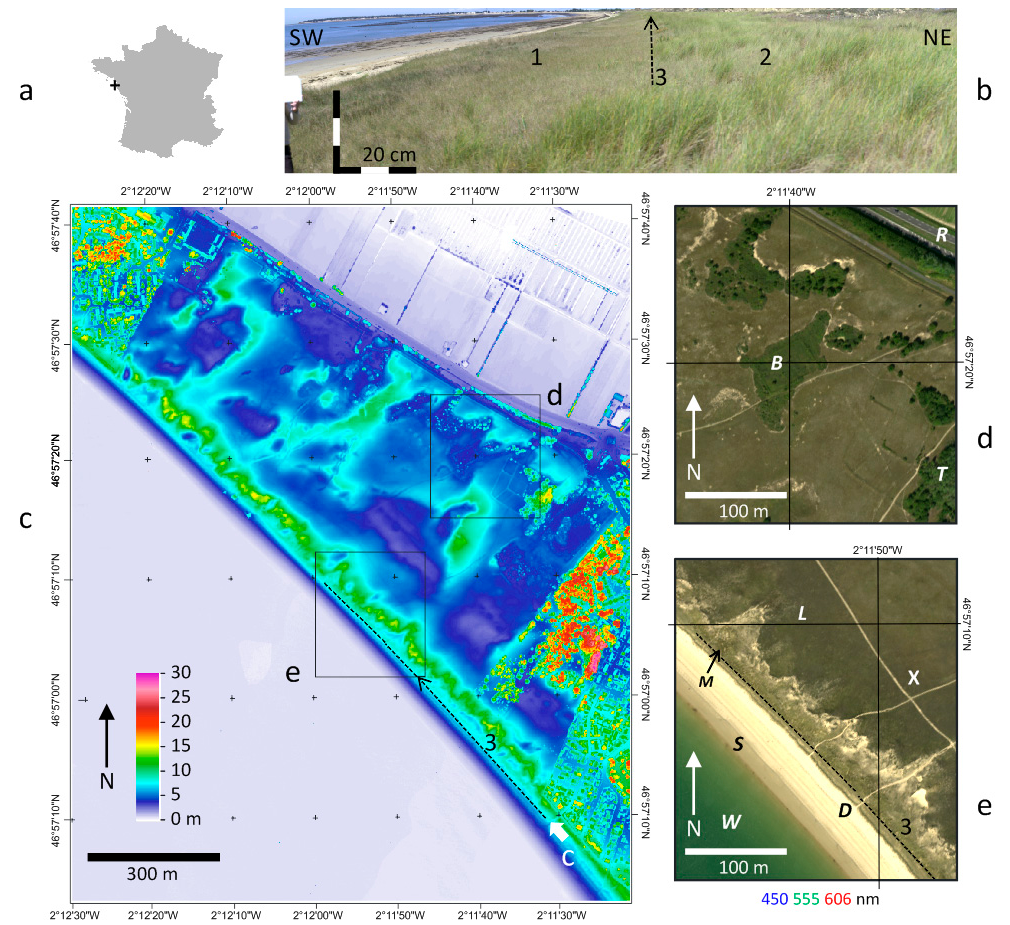
Figure 1. Localization of the study areas: ( a ) Noirmoutier island, western France; ( b ) ground panorama taken in 2017 on the axis (3) of the boundary between the couch grass on the left (1) and marram grass on the right (2); ( c ) digital surface model of the Tresson dune bordered by woods and partly urbanized in the northwestern and southeastern ends, cultivated polders on the northeastern side, and the Atlantic ocean at low tide on the southwestern side and the location of ( b , d , e ); ( d ) first area of interest (AOI 1) showing bush (B), trees (T), and an asphalt road (R); and ( e ) second main area of interest (AOI 2) showing sea water (W), bottom wet sand (S), top dry beach sand (D), mobile dune marram grass (M), fixed dune land (L), and a sandy footpath (X).